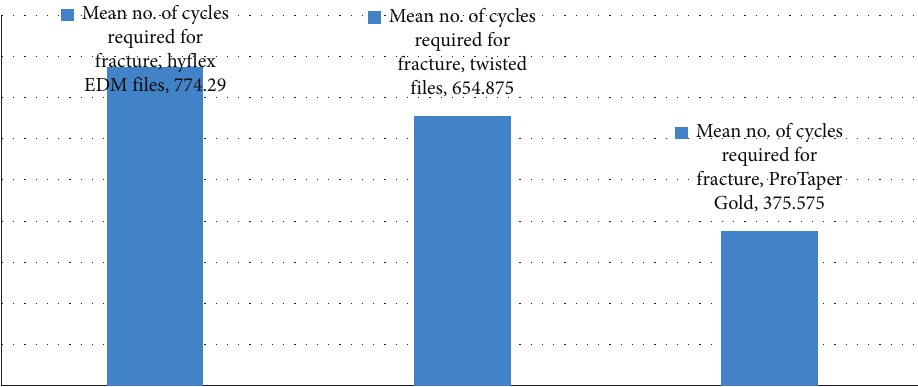
Figure 3: Mean number of cycles required for